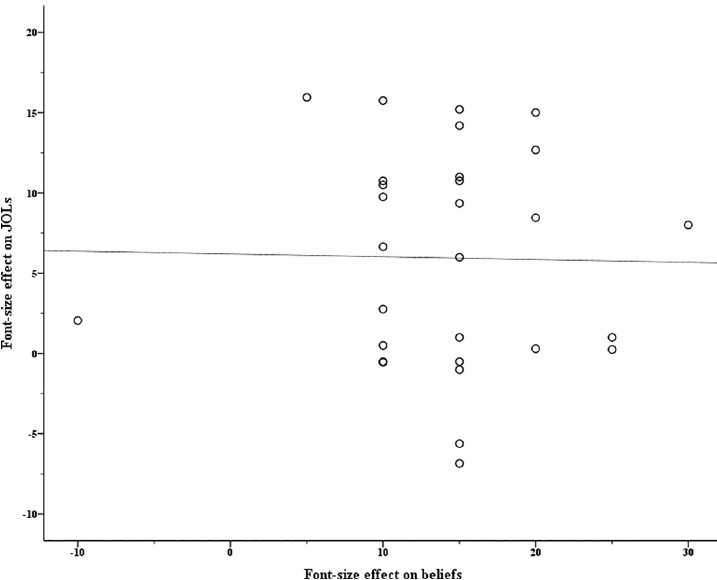
Fig 2. The relationship between font-size effects on beliefs and JOLs in Experiment 1. The font-size effect on beliefs is measured as the difference in belief-based predictions between large and small words. The font-size effect on JOLs is calculated as the difference in mean JOLs between large and small words. Each point represents one individual